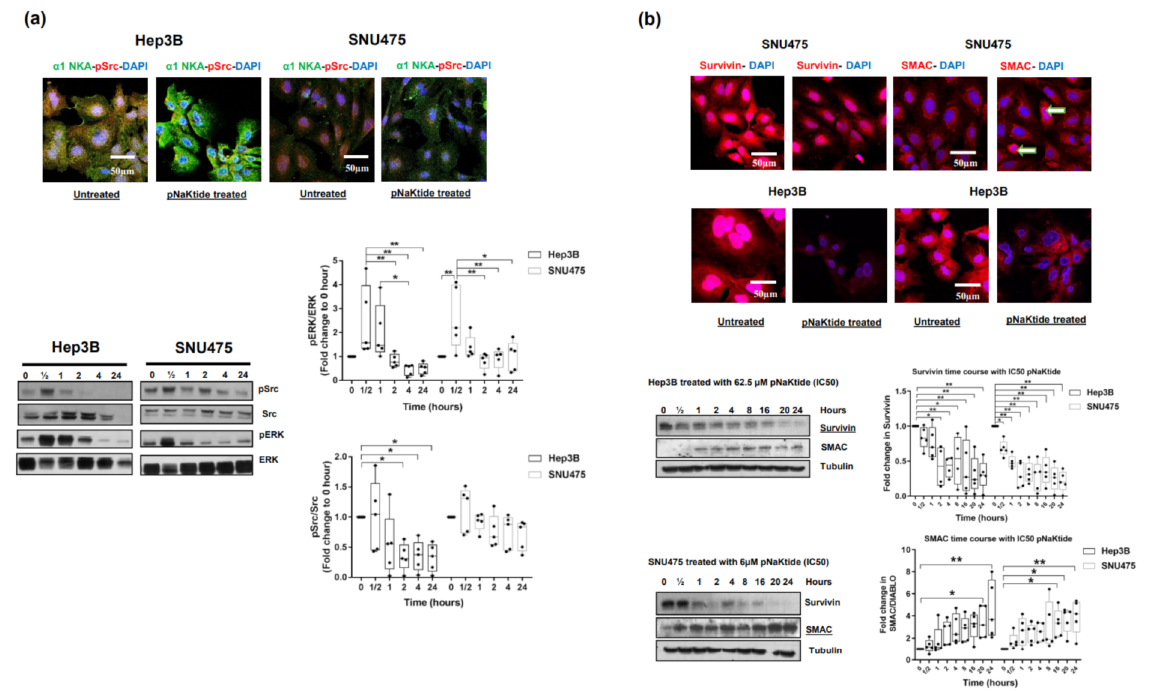
Figure 2. Effect of α 1-Na/K-ATPase signalosome normalization on pSrc, Survivin and SMAC protein expressions in Hep 3B and SNU475 cell lines. ( a ) Confocal microscopy images of the effect of pNaKtide on Src expression and a 24 h time course by western blotting in two human HCC cell lines. Box-whisker plots are showing a fold change in each protein relative to baseline at 0 h ( n = 5, * p < 0.05, ** p < 0.01). ( b ) Confocal microscopy images of survivin and SMAC protein expressions in two human HCC cell lines IC50-pNaKtide treated vs. non-treated cells and a 24 h time course analysis by western blotting. There was a significant progressive decrease in survivin expression with concomitant increase in SMAC levels over time ( n = 5, * p < 0.05, ** p < 0.01). An earlier effect was noted for survivin (significantly decreased for Hep3B at 2 h and for SNU475 cells at 30 min) when compared with SMAC expression (significantly increased for Hep3B at 20 h and for SNU475 cells at 16